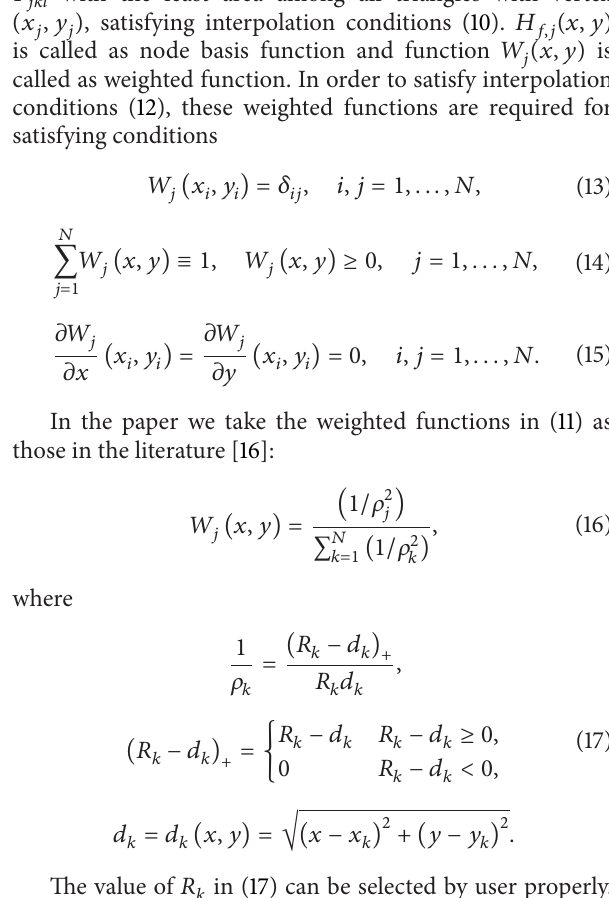
Figure 7: The graph of 𝑄 𝑓 (𝑥,𝑦) based on Figure 4.